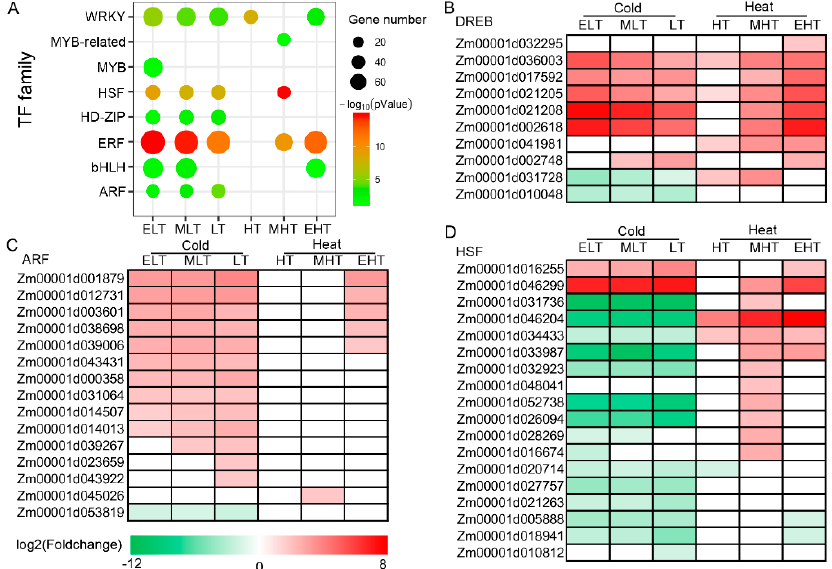
Figure 4. The enrichment analysis of transcription factors (TFs) after temperature stress (TS). ( A ) The bubble chart shows the significantly enriched TF families in response to TS. ( B ) The gene list of DREB TFs enriched after TS treatment. ( C ) The gene list of ARF TFs enriched after TS treatment. ( D ) The gene list of HSF TFs enriched after TS treatment. ELT, extreme low temperature, 4 °C; MLT, medium low temperature, 10 °C; LT, low temperature, 16 °C; NT, normal temperature, 25 °C; HT, high temperature, 37 °C; MHT, medium high temperature, 42 °C; and EHT, extreme high temperature, 48 °C.